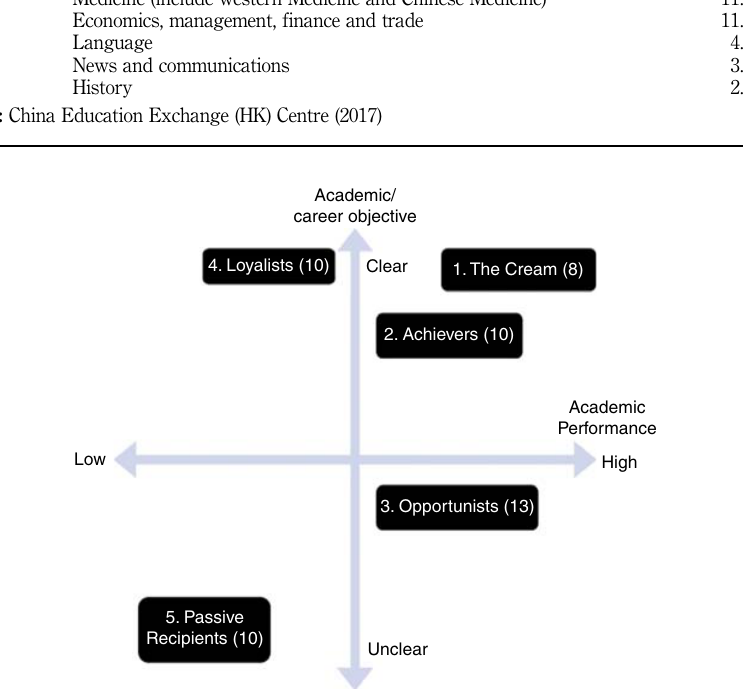
Figure 3. Five scenarios of students ’